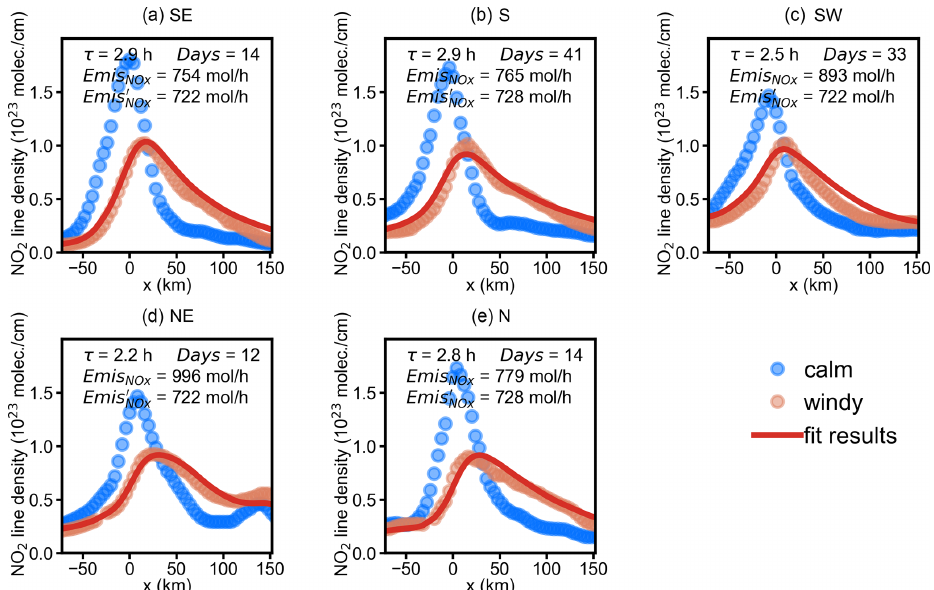
Figure 4. NO 2 line densities around New York for different wind direction sectors. Circles: NO 2 line densities for calm (blue circles) and (a) southeasterly, (b) southerly, (c) southwesterly, (d) northeasterly, and (e) northerly winds (red circles) as a function of the distance x to the center of New York. Red line: the fit result f ( x ). The numbers indicate the fitted NO x lifetime ( τ ), average days of data used for calculating ). NO 2 line densities are derived from NO 2 VCDs NO 2 line densities (days), derived emissions (Emis NO ), and given emissions (Emis (cid:48) NO x x averaged from April through September 2016. NO 2 line densities for the remaining wind direction sectors are discarded due to the fitting results having insufficient